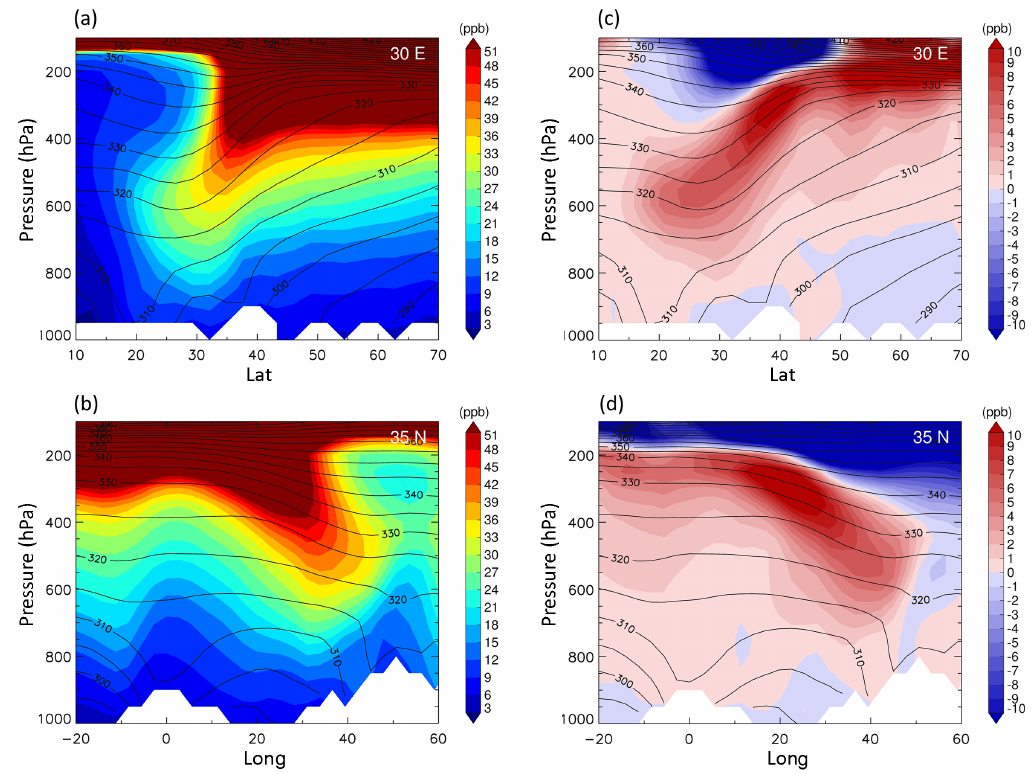
Figure 6. Latitude–pressure cross sections at 30 ◦ E of (a) O 3 s during the selected fold events and (c) the anomalies from the remainder of the summer time steps. Longitude–pressure cross sections at 35 ◦ N of (b) O 3 s during the selected fold events and (d) the anomalies from the rest of the summer time steps. Black contours denote potential temperature (K) during the selected fold